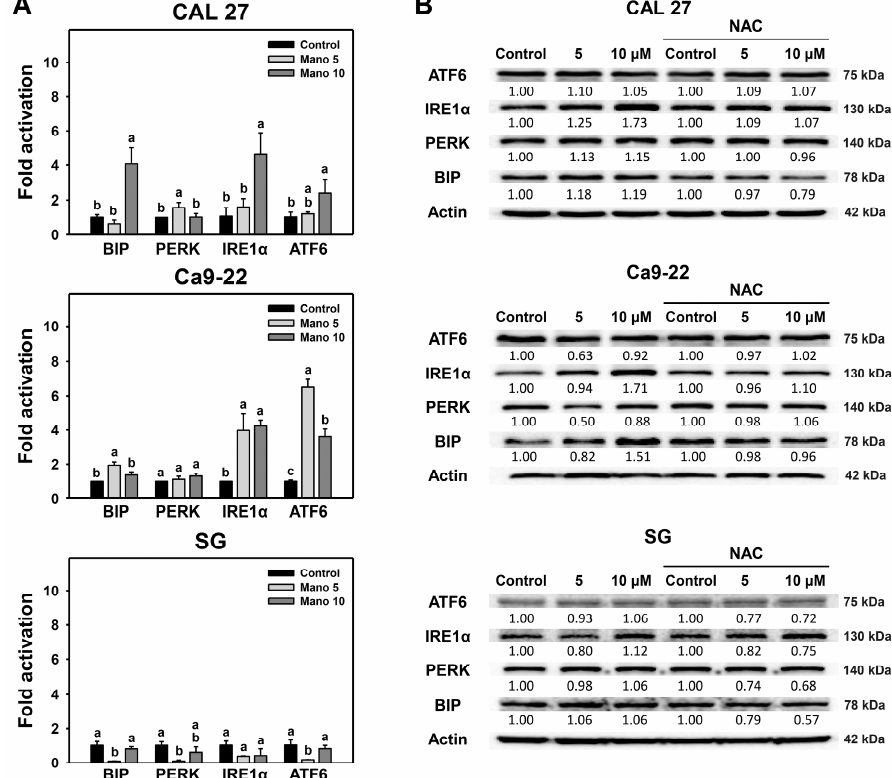
Figure 3. Manoalide causes ER stress gene expression of oral cancer cells. ( A ) Relative mRNA expressions (fold activation) of ER stress genes. Oral cancer and normal oral (SG) cells received control, 5, and 10 µ M manoalide treatments for 24 h. Data, means ± SDs ( n = 3). Multiple comparisons were analyzed for the same cell lines. For the same gene, treatments marked with different notes indicate a significant difference ( p < 0.05 to 0.0001). ( B ) NAC effects on Western blotting for ER stress signaling. Following NAC (10 mM for 1 h), cells received manoalide treatment (control, 5, and 10 µ M) for 24 h, i.e., NAC/Mano.